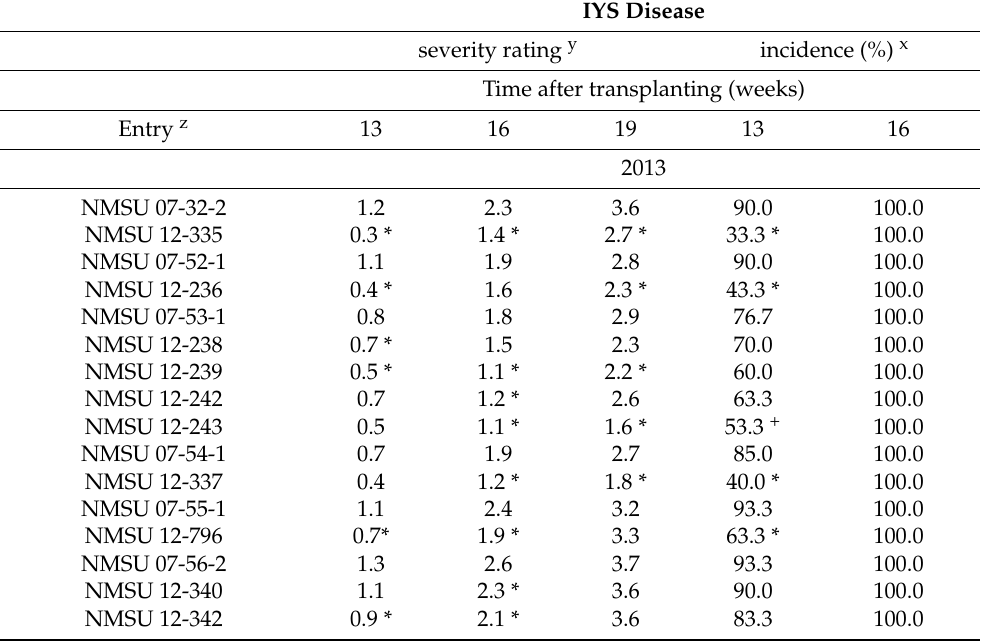
Figure 3. From left to right, IYS symptoms on plants of susceptible check: ‘Rumba’ ( A ), original population NMSU 07-54-1 ( B ), and selected breeding line NMSU 12-337 ( C ) when grown in field conditions conducive for disease development. Table 1. Mean values and comparisons of selected breeding lines with original populations for Iris yellow spot (IYS) severity rating and incidence measured several times throughout the 2013 and 2014 growing seasons at the Leyendecker Plant Science Research Center in Las Cruces, New Mexico,